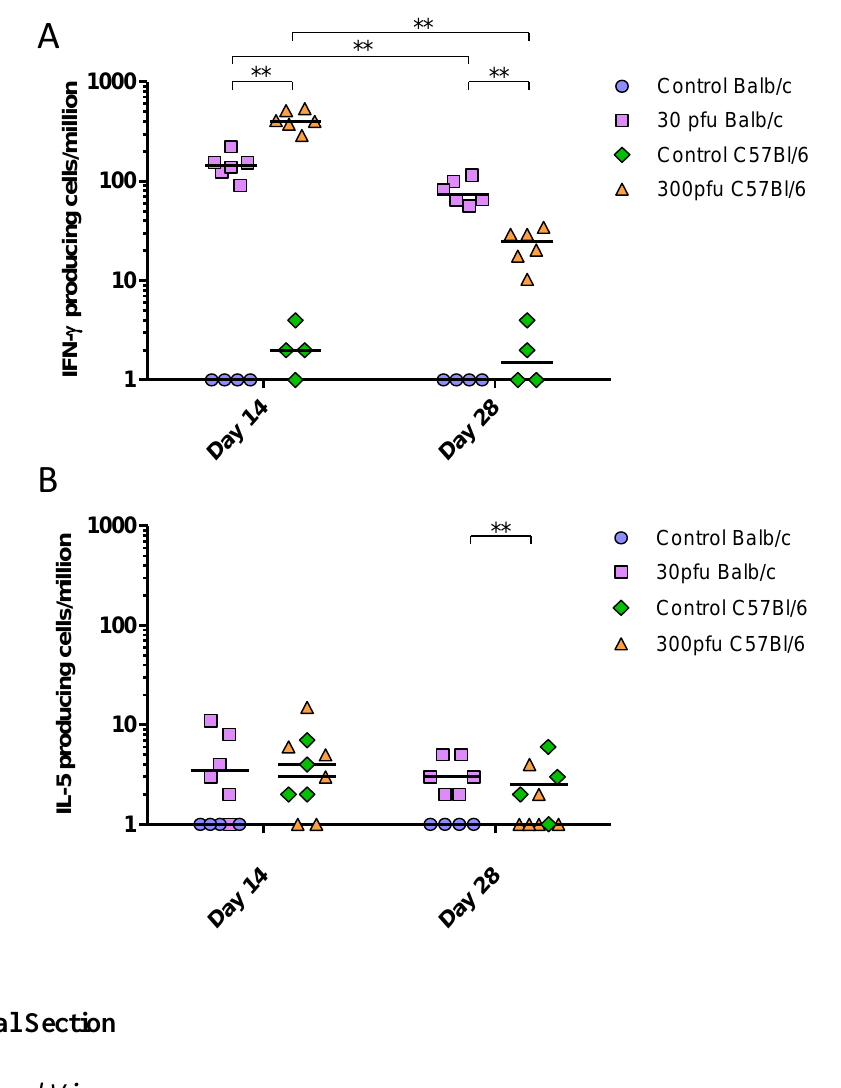
Figure 8. PVM-specific IFN-γ-secreting ( A ) and IL-5-secreting ( B ) splenocytes following in vitro restimulation with PVM-infected cell lysates. Five to six week-old Balb/c and C57Bl/6 mice were inoculated with medium, 30 pfu (Balb/c) or 300 pfu (C57Bl/6) and sacrificed on days 14, 28, and 42 p.i.. The PVM-specific response is calculated by subtracting the number of cytokine-secreting